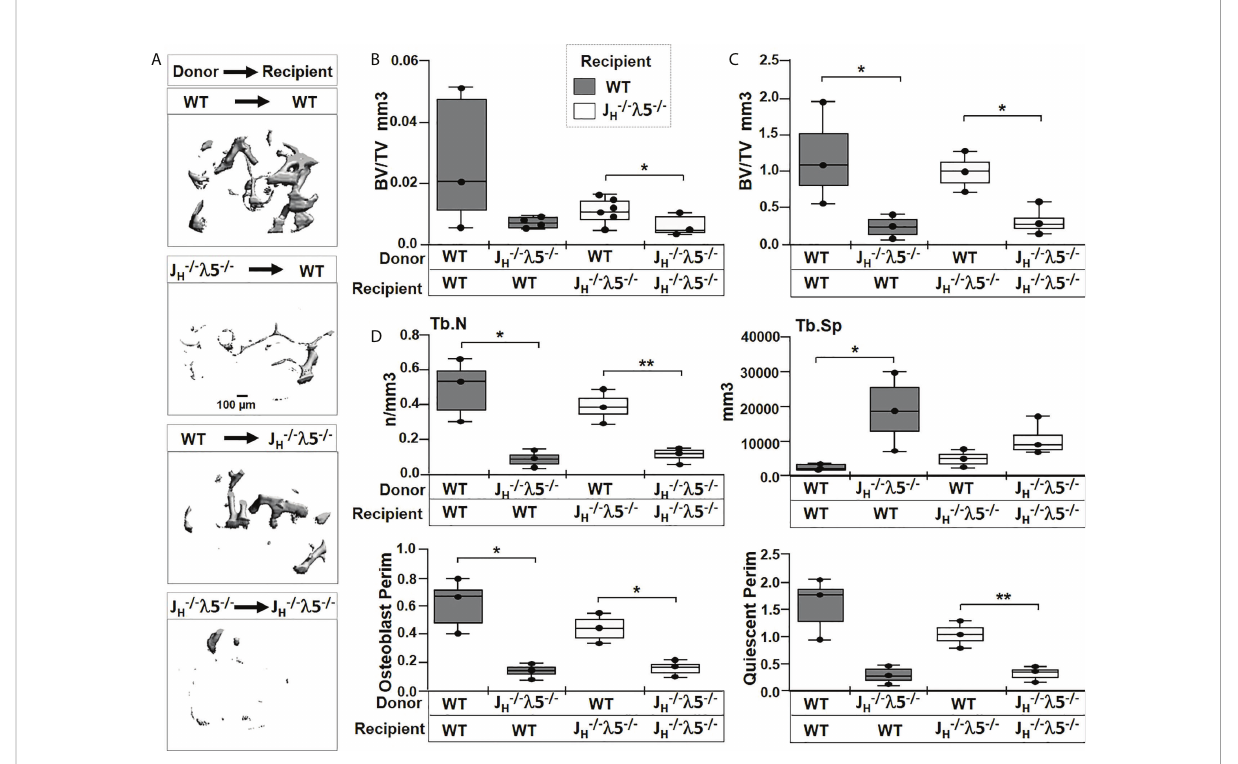
FIGURE 7 Transfer of l 5-suf fi cient whole marrow cells rescue trabecular bone in J H-/- l 5 -/- mice. (A) Representative µCT images of trabecular bone in femurs of radio-ablated WT or J H-/- l 5 -/- females reconstituted with J H-/- l 5 -/- or WT whole bone marrow cells. Femurs were analyzed six months after marrow reconstitution. (B) Quanti fi cation of the bone volume over total volume (BV/TV) from µCT analysis, and (C) from histomorphometric analysis of the same femur after histologic processing. (D) Selected bone parameters quanti fi ed from the histomorphometric analysis of indicated genotypes are shown in bar graphs. Trabecular numbers (Tb.N); Trabecular spacing (Tb.SP); Osteoblast Perimeter (Osteoblast Perim), Quiescent Perimeter (Quiescent Perim). Data were obtained from n=3-5 mice per group. The experimental data are the average of three repeats. Statistical signi fi cance was calculated by ANOVA. *p<0.05, **p<0.01. Scale bar: